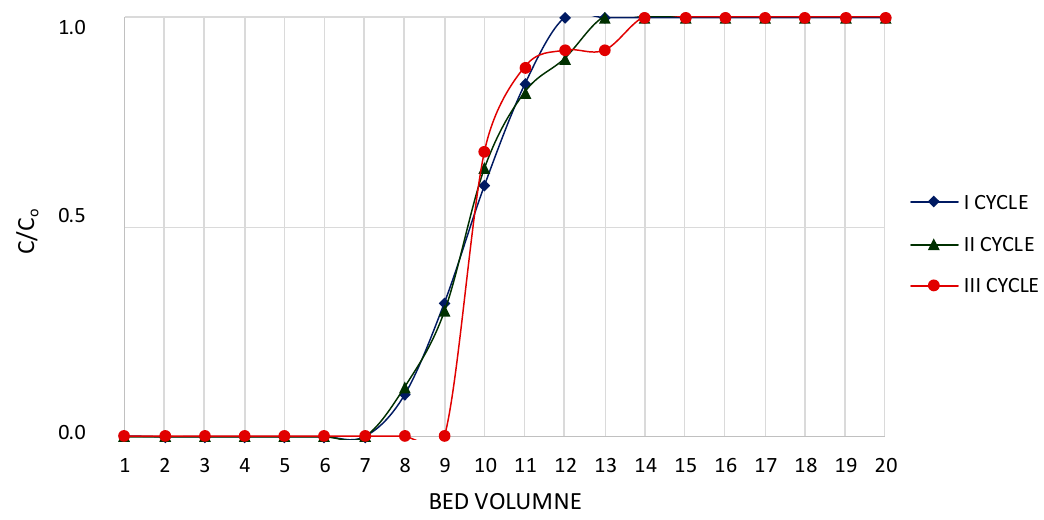
Figure 3. Characteristics of PFC100x10 during sorption. Table 8. Parameters for rubidium ion sorption—PFC100x10.